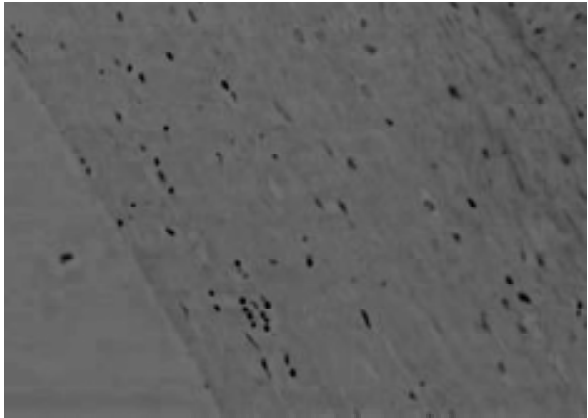
Figure 2. Microphotography of the coronary arterial wall. Slight inflammatory reaction with coronary wall showing leukocytic infiltration in the tunica intima and tunica media. (hematoxylin- eosin; 100X